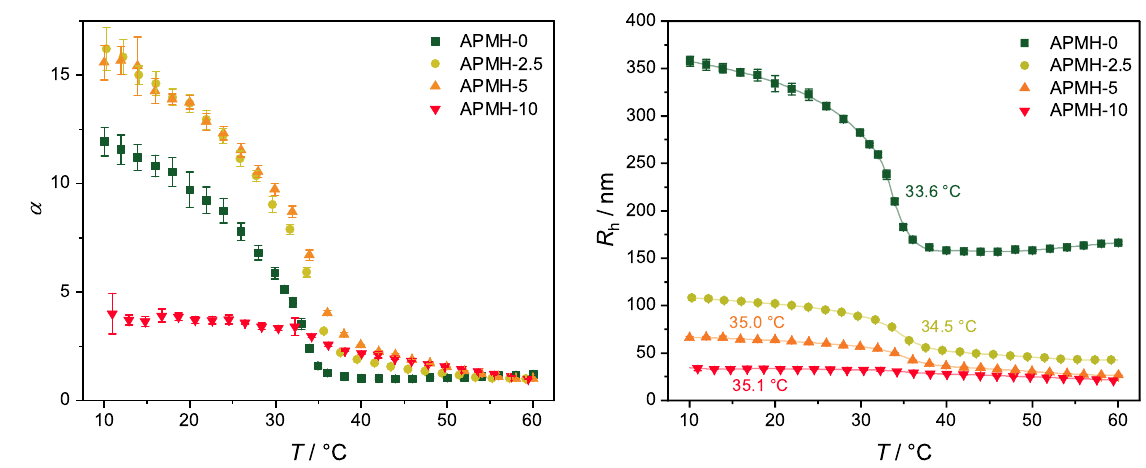
Figure 2. Temperature-dependent swelling behavior of the synthesized particles, shown by means of the hydrodynamic radius R h and the swelling ratio α . The corresponding VPTTs, determined from the point of inflection of cubic B-splines, are given in the right